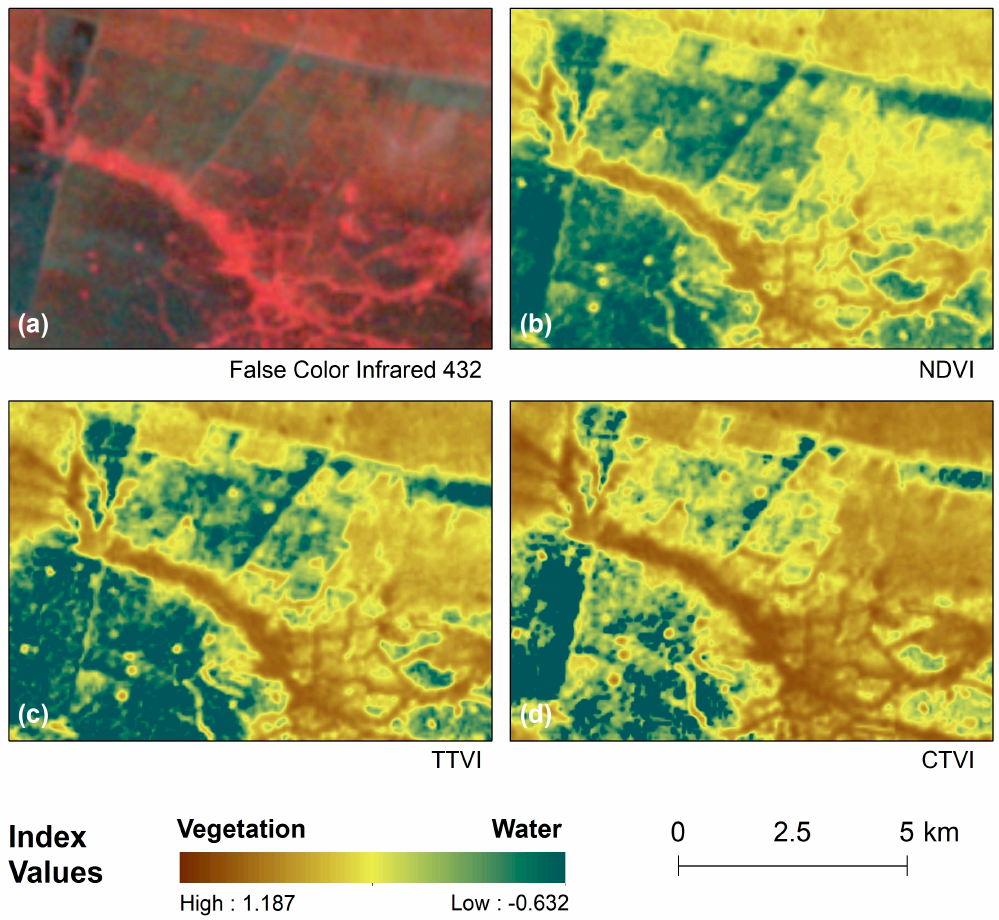
Figure 7. 1979 image of Banteay Meanchey, Cambodia. False color infrared composite compared to normalized difference vegetation index (NDVI), Thiam’s transformed vegetation index (TTVI), and corrected transformed vegetation index (CTVI) results. In the false color image ( a ), haze obscured flooded areas and boundaries between water and land were hard to define. In the NDVI ( b ), the contrast between wet areas (blue) and farmland (yellow to brown) was much clearer, but boundaries still remained blurred. The TTVI ( c ) isolated the water signal but overemphasized it. This could be seen in the lower left corner of the image, where the large blue (water) area has the same index value on both sides of the dividing dike, showing a uniform blue shade across the entire section. Contrast this to the same area in ( a , b ), where there was a stronger (darker) water reading on the left side. CTVI ( d ) results showed the clearest distinction between water storage and flooded fields, and proved the most successful in defining borders between fields (pale blue) and water storage structures (darker solid blue).